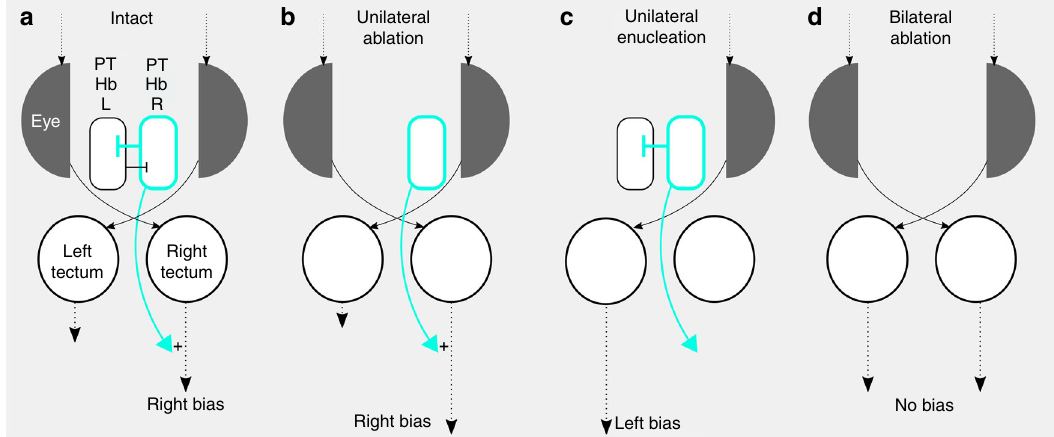
Fig. 7 Motor asymmetry in zebra fi sh. a For a right-biased larva, the dominant right PT-habenula pathway imposes right motor bias by modulating symmetric visual drive and suppressing the left PT-habenula pathway. b Competition between PT-habenula units is eliminated after unilateral ablations, strengthening motor bias. c Asymmetric visual input after unilateral enucleation overrides PT-habenula modulation of motor output. d Symmetric visual stimuli, after bilateral ablation of PT-habenula units, eliminate motor bias leading to randomized turn